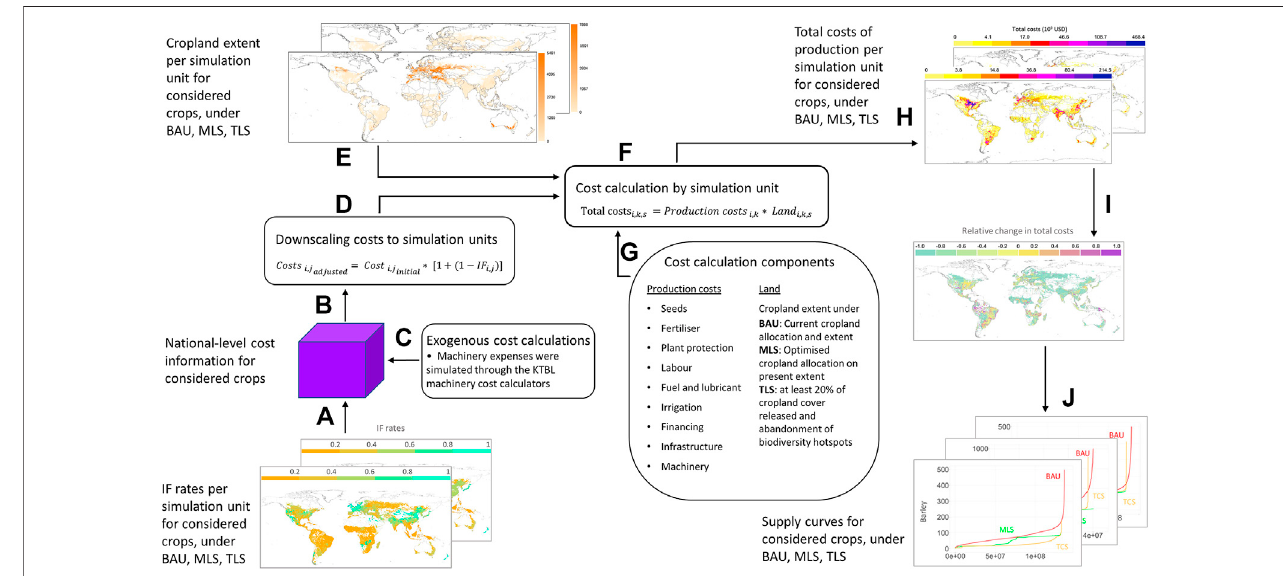
FIGURE1| Schematicdesignofthestudy, (A – J) .Intensi fi cationfactor( IF )rates (A) werecalculatedintroducinginput-outputrelationshipsatasimulationunitbasis using physical information on current and attainable yields and corresponding nutrient requirements derived from SPAM 2010 v1.1 (47) (this data was scaled up and to match food production volumes during the reference period of 2011 – 2015 using FAOSTAT reported values on production of the ten crops considered) and the EPIC- IIASA global gridded crop model, respectively. IF rates are combined with national-level cost information (B) and the exogenously simulated (through KTBL plant processcostcalculators)machineryexpenses (C) todownscalecostsatsubnationalscales,inasimulationunitbasis (D) .Croplandextent (E) fortheconsideredcropsin BAU was obtained from SPAM 2010 v1.1 (similarly to yields, data was scaled up to match food production volumes around the baseline year) while in MLS and TLS cropland was derived from Folberth et al. ’ s optimised land-use datasets. Physical and fi nancial information covering nine cost elements for the three examined production scenarios (G) is combined in the cost calculation function (F) . Costs are then aggregated to total costs for all crops per scenario (H) to assess cost effectivenessatglobalscalesandalsoevaluaterelativechangeintotalcostsatasimulationunitspatialresolution (I) .Finally,relationshipsbetweenglobalfoodproduction and associated costs of production by crop commodity and production scenario are evaluated in the context of global food supply curves (J) .